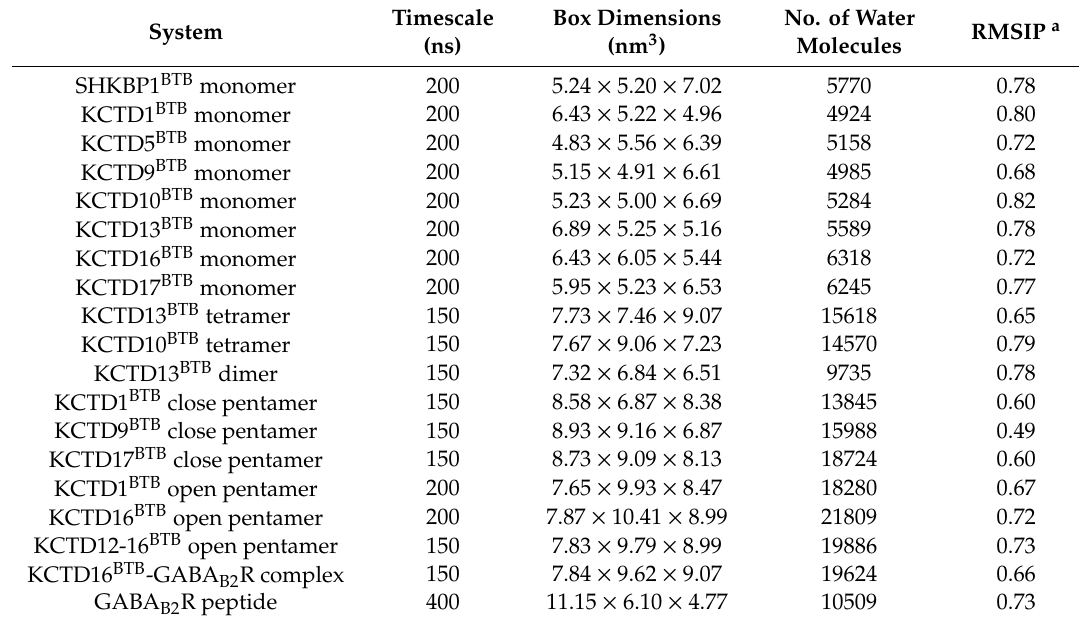
Table 1. Parameters and statistics of MD